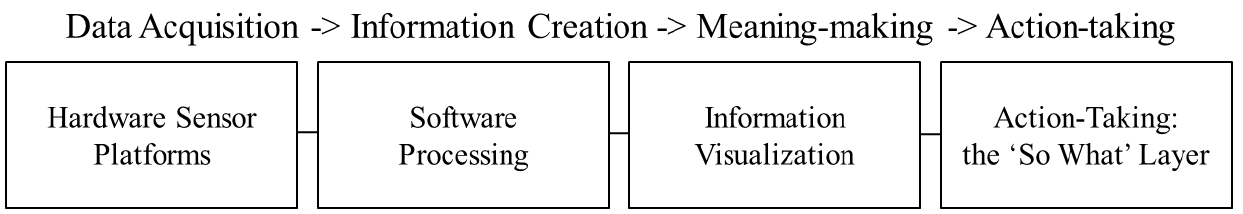
Figure 2. Processes and Layers in the Internet of Things